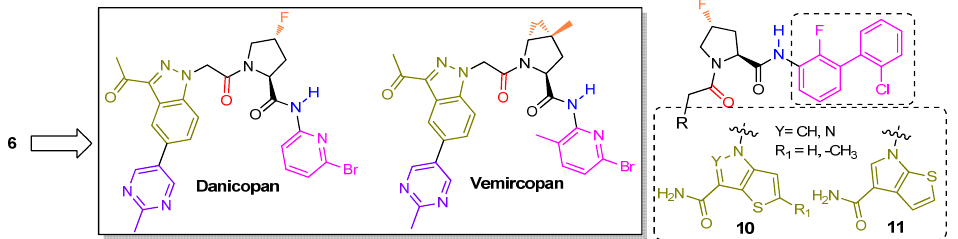
Figure 7. Both danicopan and vemircopan are very close replicas of molecule 6 , having a methyl- substituted pyrimidine ring attached to one of the indazole carbon atoms. Our own modeling studies of danicopan (not included in this review) revealed that the added pyrimidine ring is oriented towards solvent space and therefore should have no impact on its binding affinity.